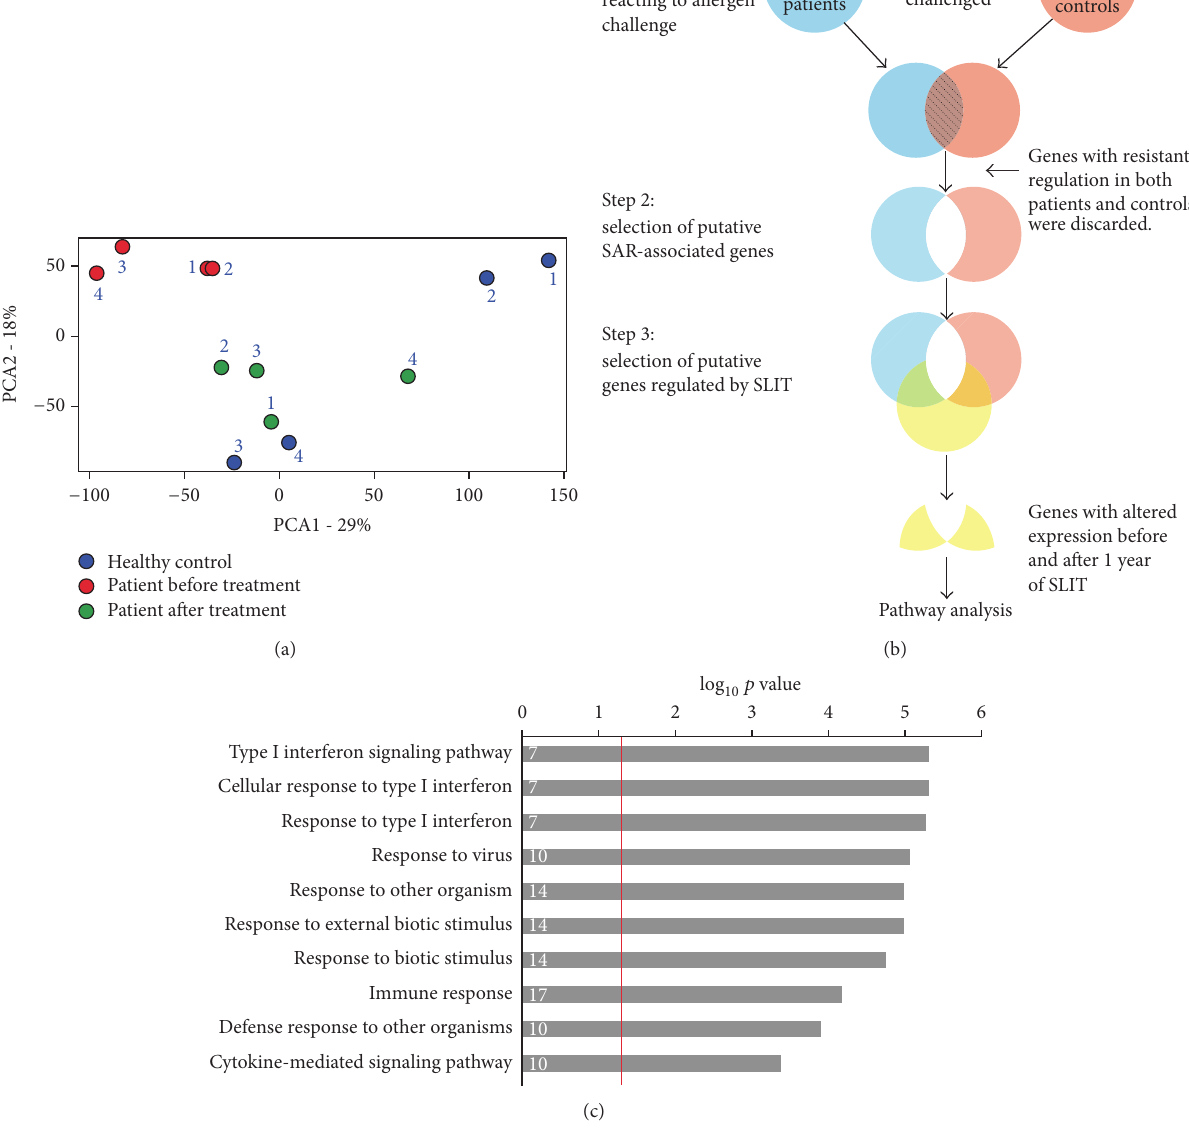
Figure 1: The sublingual immunotherapy alters the signaling of type I interferons in patients with seasonal allergic rhinitis. (a) The principal component analysis (PCA) plot gives an overview of the differentially expressed genes in patients before and one year after treatment as well as healthy controls. (b) The workflow of the selection of putative genes regulated by SLIT. (c) GO term enrichment of genes reacting to SLIT treatment using AMIGO. The numbers in the bars represent numbers of genes identified for each term. The 𝑝 value comes from the comparison of patients before SLIT and after one year of SLIT in step 3 in (b). Red line is 𝑝 value 0.05 ( − log 10 =